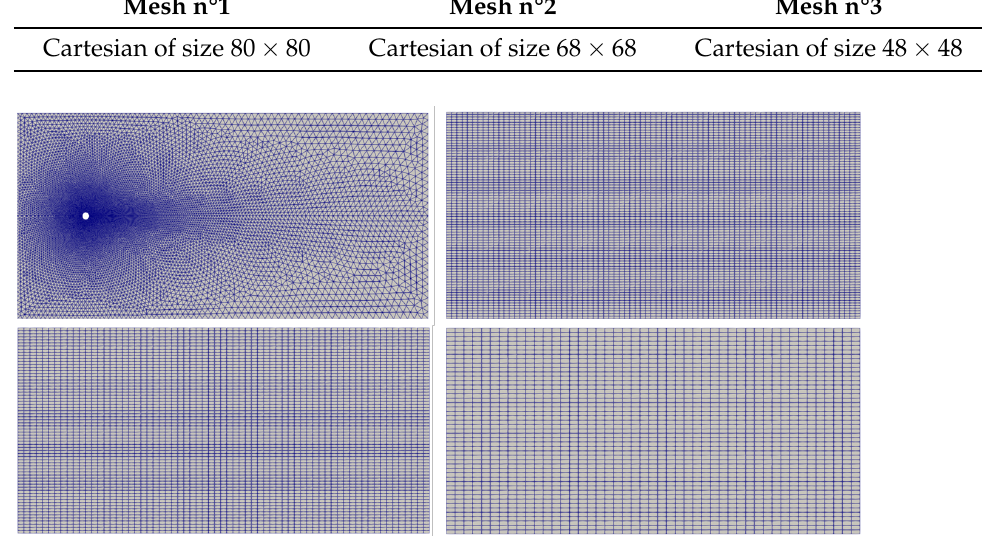
Figure 1. On the top left, we find the high-fidelity mesh. On the top right, we find mesh n°1. On the bottom left, we find the mesh n°2. On the bottom right, we find the mesh n°3. A snapshot of the first component of the velocity field is shown in Figure 2. We enlarged the grid details to show closely the flow structures and vortices past the circular cylinder.